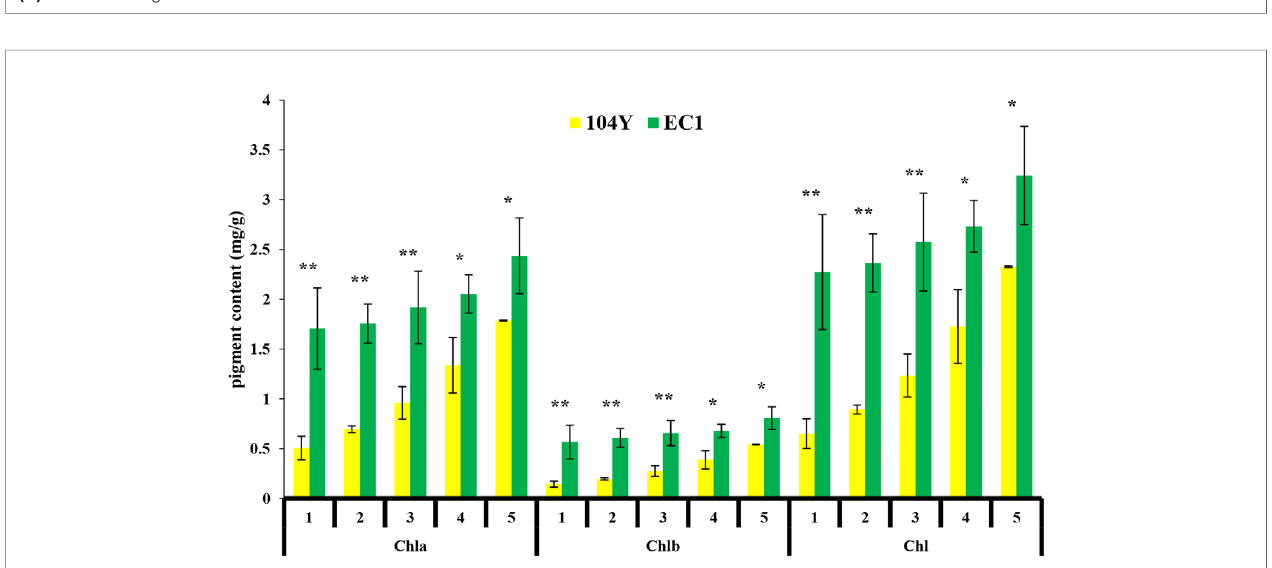
FIGURE 2 | Chlorophyll a (Chla), Chlorophyll b (Chlb), and total chlorophyll (Chl) contents in milligrams per gram offresh weight from the fi rst true leaves to the fi fth true leaves in 104Y and EC1. Data are mean ± SD (n = 3). Error bars represent SD of three independent replications. *, **: Signi fi cant at 5% and 1% level, Fine Mapping and Candidate Gene markers NR91 and SSR20578 on the chromosome 3 ( Figure 5A ). Identi fi cation of v-2 Locus These results of BSA-seq and linkage analysis validated with each other, and con fi rmed that the v-2 locus was mapped to 36.9-38.7 Initial mapping located the v-2 locus between markers NR91 and Mb on chromosome 3. SSR20578 on chromosome 3. To further narrow down the